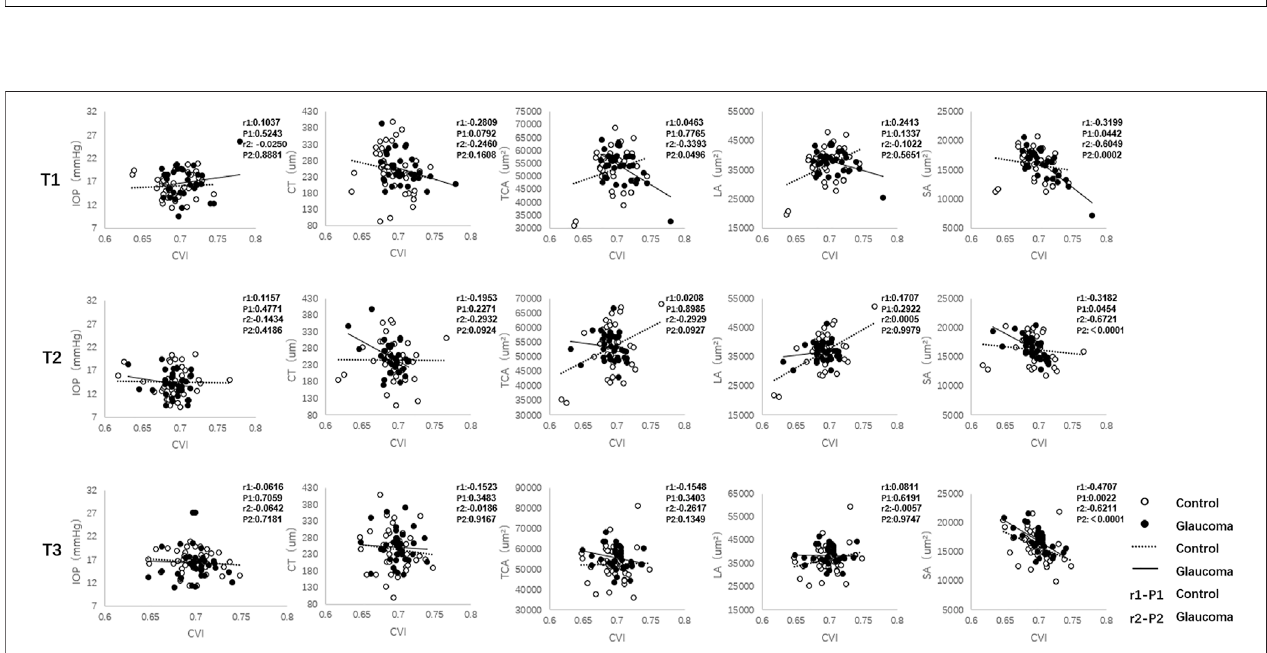
FIGURE 3 | The correlation between the choroidal vascularity index (CVI) and intraocular pressure (IOP) and other choroidal parameters (CT, TCA, LA, and SA) in the glaucoma and control groups. CT = choroidal thickness, TCA = total choroidal area, LA = luminal area, SA = stromal area.